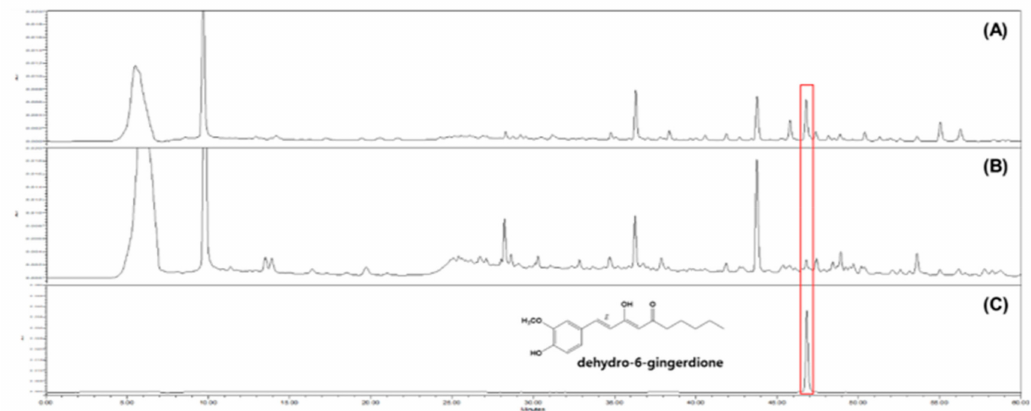
Figure 5. HPLC spectra of GG03 ( A ; 10,000 ppm) and GE ( B ; 10,000 ppm) and 1-dehydro-6-gingerdione ( C ; 100 ppm). HPLC analysis was carried out as described in the Materials and Methods section. Quantitative analysis was replicated three times. Chromatograms shown represent the best of three